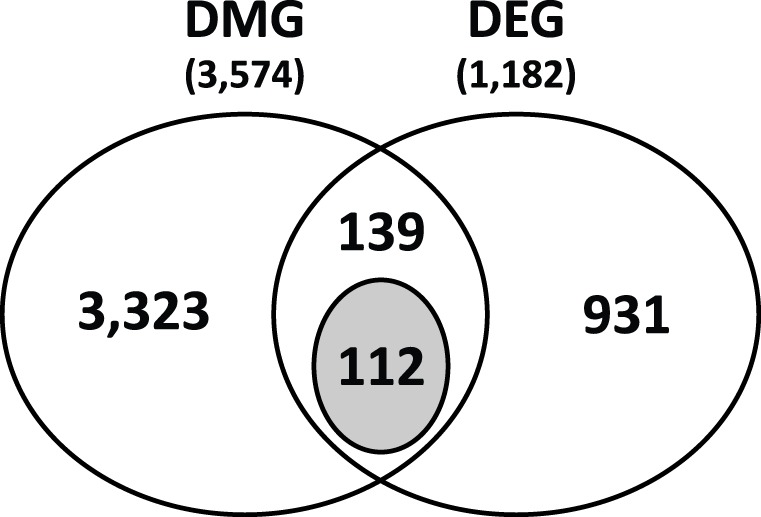
Overlapping of DMGs and DEGs.Identified DMGs and DEGs were compared for overlapping. Among 3,574 DMGs and 1,182 DEGs, 251 genes were common. Among these shared genes, 112 genes had concordant direction of change in methylation and expression (hyper-methylation with down-regulation or hypo-methylation with up-regulation) (shaded circle).